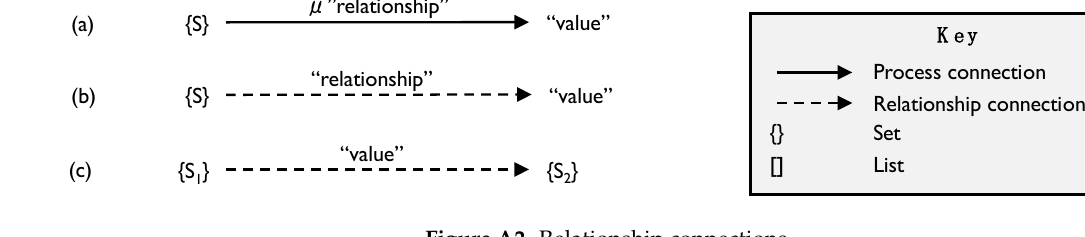
Figure A2. Relationship connections.